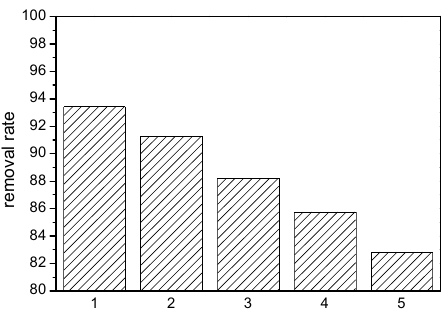
Figure 6. Recycling of MAG-Fe 3 O 4